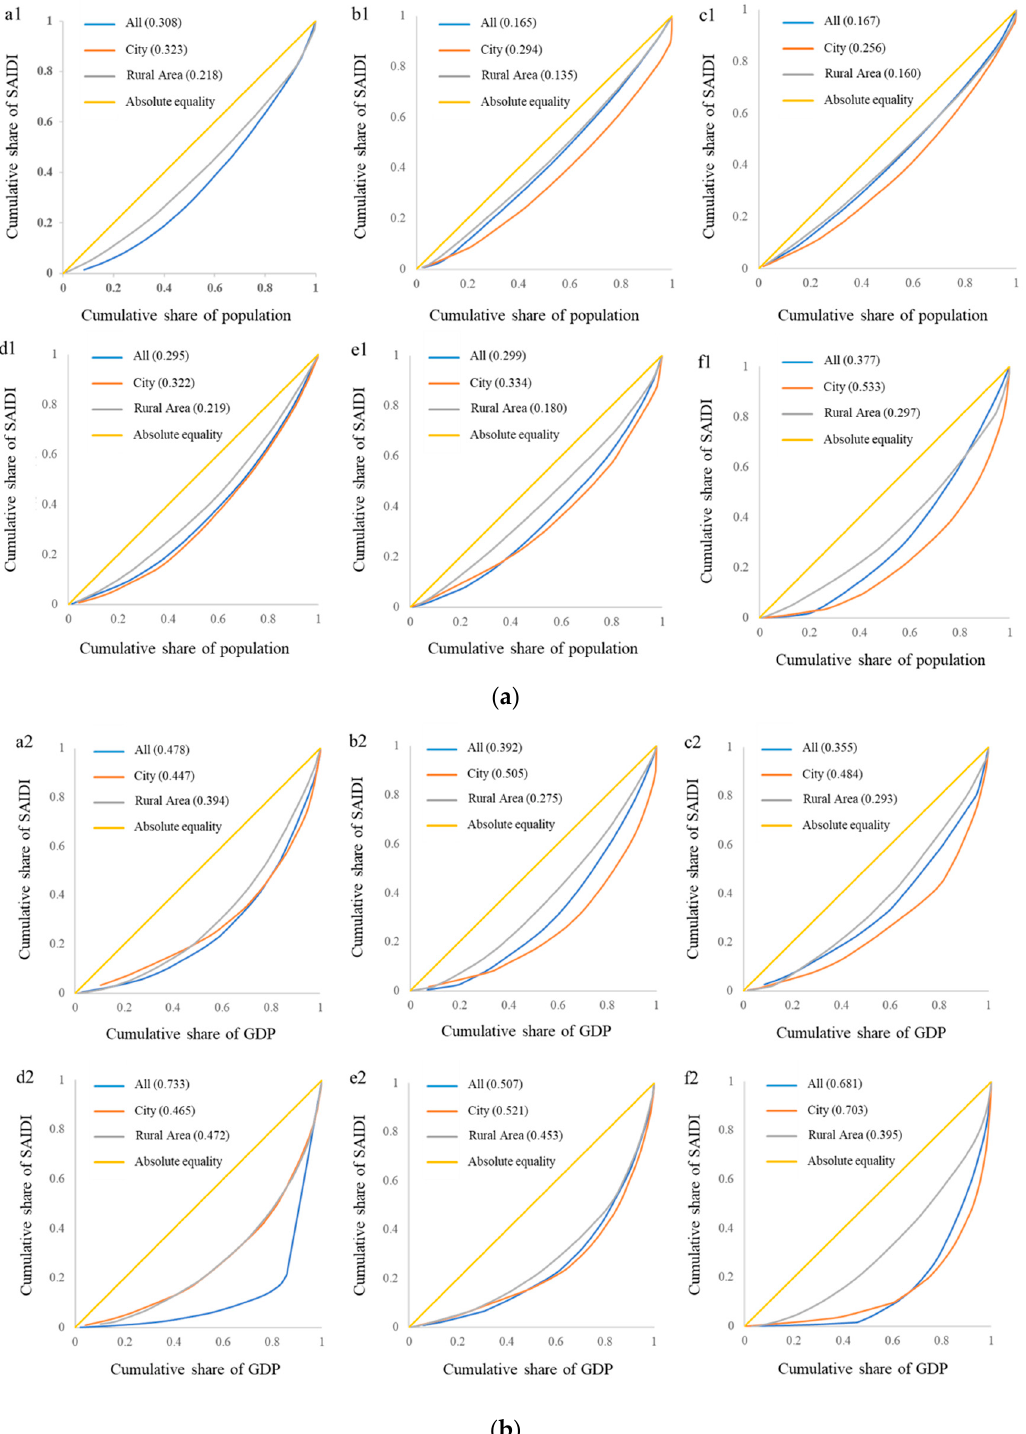
Figure 3. Lorenz curve by regional power grid companies. ( a ) Lorenz curve with cumulative share of population on the horizontal axis. ( b ) Lorenz curve with cumulative share of GDP on the horizontal axis. Numbers 1–6 represent power grid companies in North China, Central China, Northeast China, East China, Northwest China and Southwest China, respec- tively.